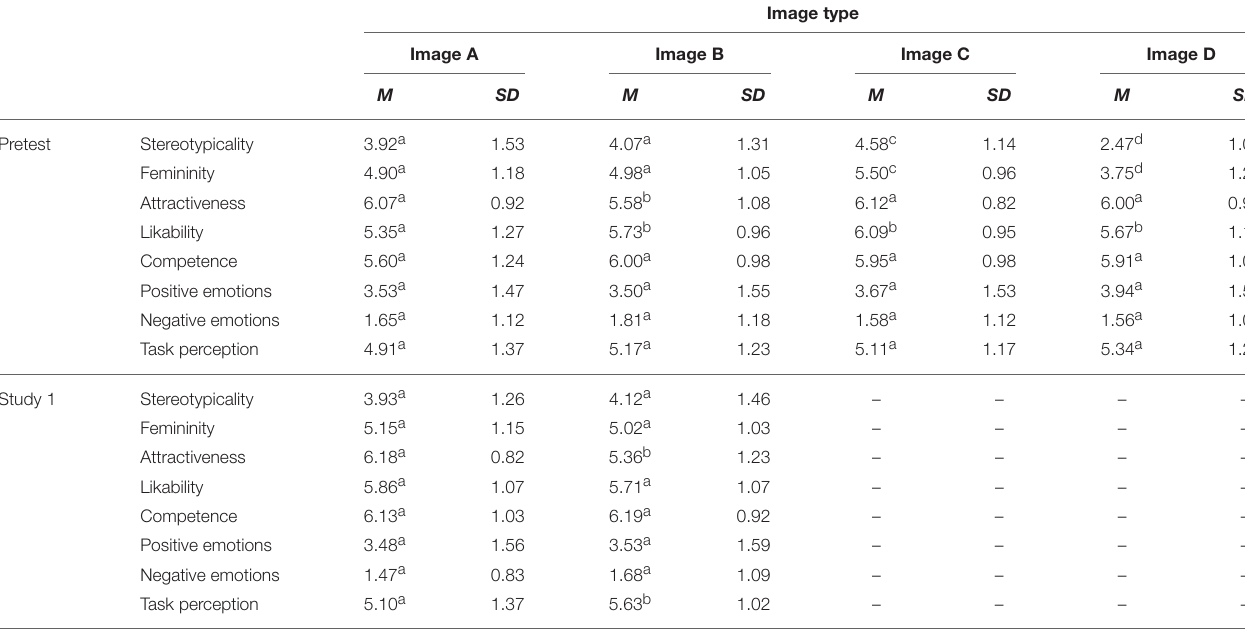
TABLE 1 | Differences in the ratings of the four stimuli in Pretest Study and in Study